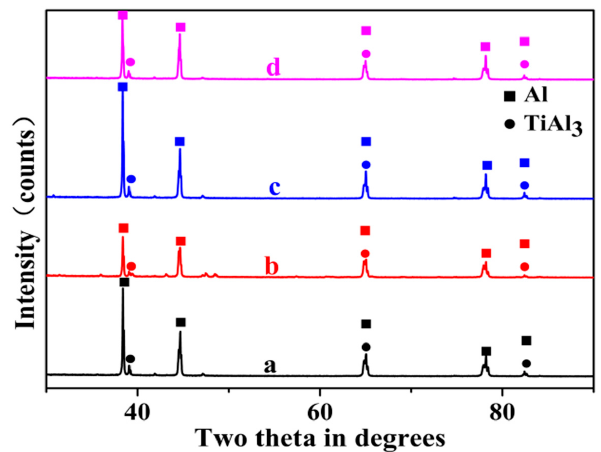
Figure 4. X-ray diffraction (XRD) patterns of Al–4Ti master alloys solidified at different cooling rates: ( a ) 3.36 K/s; ( b ) 2.57 K/s; ( c ) 1.65 K/s; ( d ) 0.31 K/s.